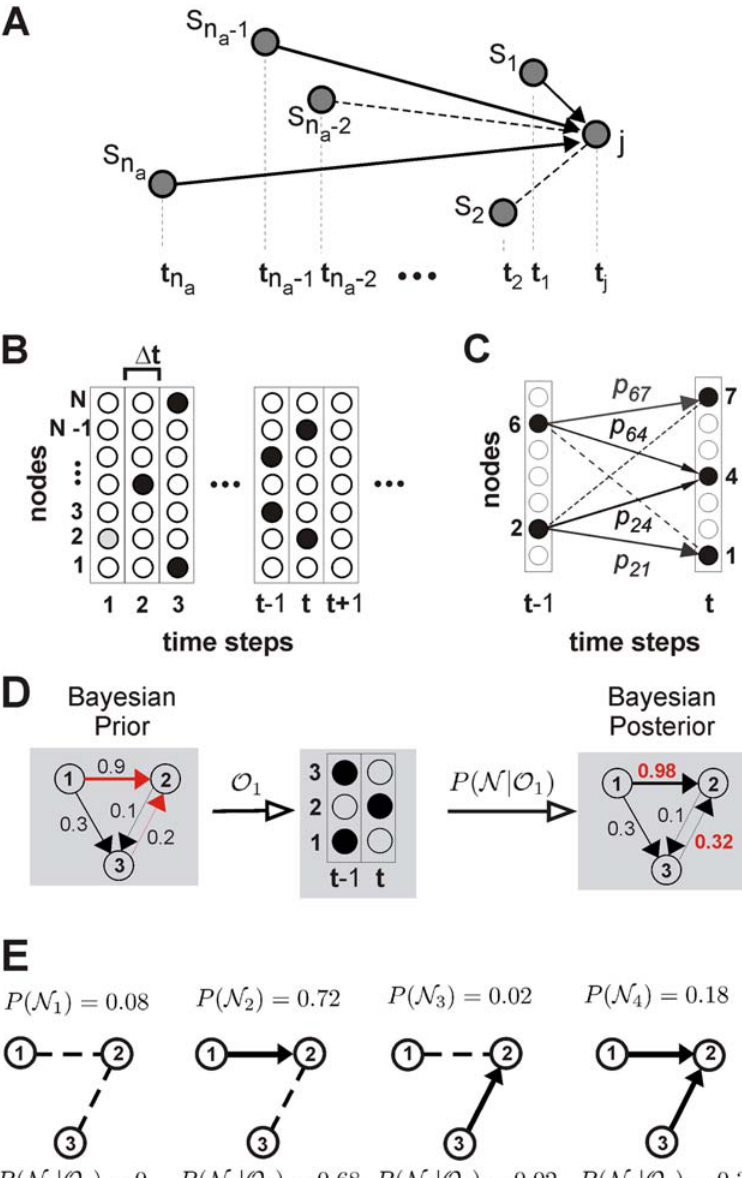
Figure 1. Bayesian network reconstruction from cascade dynamics. (A) The basic subnetwork motif for the Bayesian method consists of a target node j and n a active source nodes s l recorded as pairs s l , t l ð Þ indicating the node and the time for each event. All possible network configurations N c with n a source nodes will be explored. A particular configuration with n a ~ 5 and n c ~ 3 existing links is shown indicating that some of the active nodes will be able to directly influence the activation of the target node j (solid line: directed link exists), whereas others will not (broken line: directed link absent). (B) Discretization of the cascade dynamics in time steps of length D t on a network with N nodes (active nodes labeled black). (C) A branching process on a network is simulated by assigning activation probabilities to each outgoing link, here between source nodes 2 and 6 and target nodes 1, 4, and 7 (broken line: link absent). (D) An example of a Bayesian estimation given the observation O 1 on a 3 node network (STES). Numbers indicate link activation probabilities. Red: links that will be modified given the target node 2. (E) The four configurations, N 1 through N 4 , when the node 2 is the target node, showing their prior and posterior probabilities for the observation O 1 shown in (D). The posterior probabilities are used to calculate new link priors in the next estimation step by summing all posterior configuration probabilities, p N c jOð Þ for those configurations containing the specific link l . For example, only the second and fourth configuration posterior probabilities are added for the link 1 R